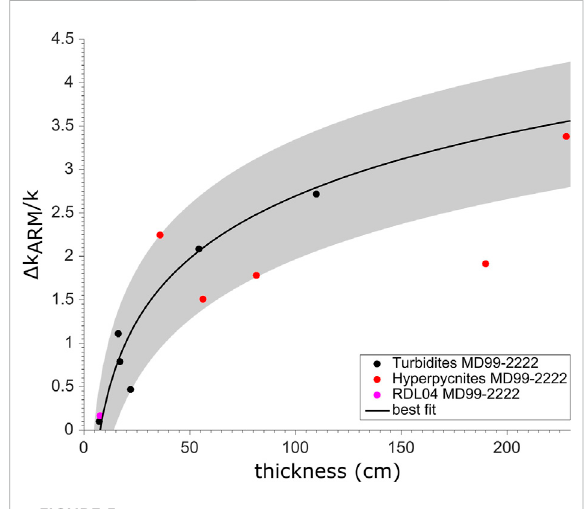
FIGURE 5 Amplitude of grain size changes within 12 RDLs as a function of their thickness. Black, red and pink closed circles are for turbidites, hyperpycnites and other RDLs from core MD99-2222, respectively.